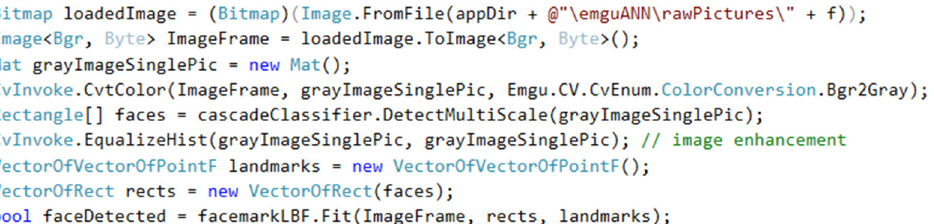
Figure 4. Viola–Jones facial extraction and landmark algorithm (own creation).